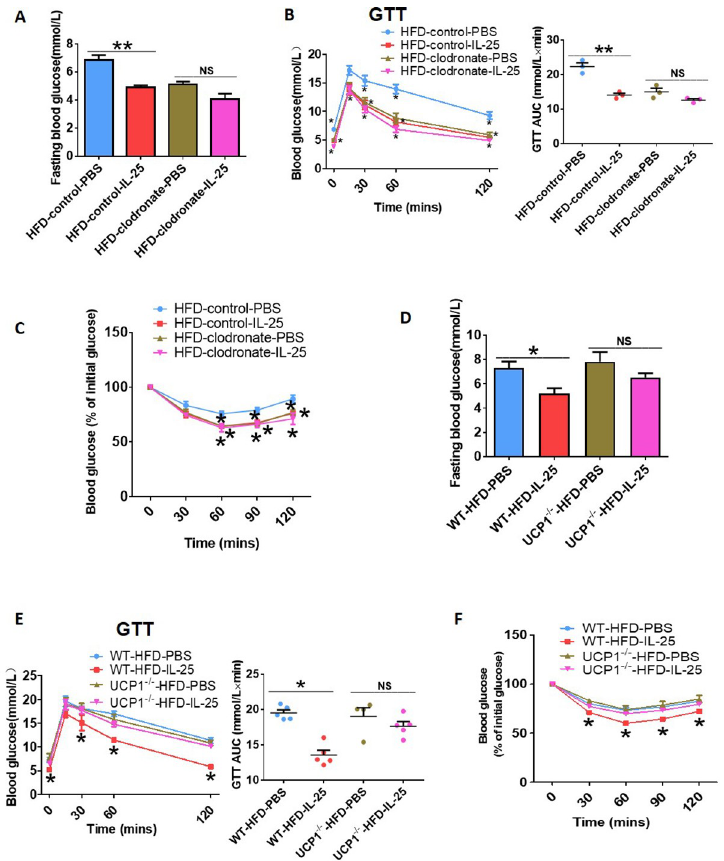
Fig 7. Depletion of macrophages and genetic deletion of UCP1 impaired the improvement of metabolic homeostasis in IL-25–induced beige fat mice. (A–C) Mice with DIO mice ( n = 5) administrated with clodronate- loaded liposomes to deplete macrophages and then injected with vehicle or IL-25 (1 μ g/day) for 14 days. (A) Changes in fasting blood glucose. (B) GTT was conducted by intraperitoneal injection of glucose (2 g � kg − 1 ) and measurement of blood glucose concentration with a OneTouch Ultra Glucometer at designed time points in overnight-fasted mice. (C) ITT was done by IP injection of insulin (0.75 U � kg − 1 ) and measurement of blood glucose concentration by a OneTouch Ultra Glucometer at designed time points in 8 h–fasted mice. � p < 0.05, compared with HFD-control-PBS group by two-sided unpaired t test. Data present as mean ± SEM. (D–F) WT (UCP1 +/+ ) and UCP1-null (UCP1 − / − ) mice ( n = 5 per treatment) were fed with an HFD for 12 weeks and then injected with IL-25 (1 μ g) or vehicle for 14 days. (D) Changes in fasting blood glucose in these mice. (E) GTT was conducted by intraperitoneal injection of glucose (2 g � kg − 1 ) and measurement of blood glucose concentration with a OneTouch Ultra Glucometer at designed time points in overnight-fasted mice. (F) ITT was done by IP injection of insulin (0.75 U � kg − 1 ) and measurement of blood glucose concentration by a OneTouch Ultra Glucometer at designed time points in 8 h–fasted mice. � # p < 0.05, compared with WT-HFD-IL-25 group, � p < 0.05, compared with WT-HFD-PBS group by two-sided unpaired t test. Data present as mean ± SEM. The data underlying this figure can be found in S1 Data. AUC, area under the curve; DIO, diet-induced obesity; GTT, glucose tolerance test; HFD, high-fat diet; IL, interleukin; IP, intraperitoneal; ITT, insulin tolerance test; AU : PleasedefineNSinFig 7 abbreviationlistifthisindeedisanabbreviation : NS, not significant; UCP1, uncoupling protein 1; WT, wild-type.